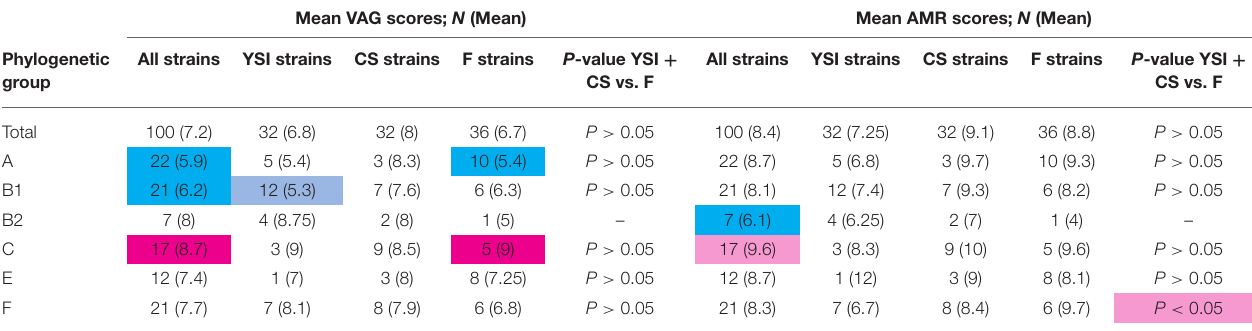
TABLE 4 | Virulence-associated genes and antimicrobial resistance scores of avian Escherichia coli isolates by phylogenetic groups. Mean VAG scores; N (Mean) Mean AMR scores; N (Mean) Phylogenetic All strains YSI strains CS strains F strains P -value YSI + All strains YSI strains CS strains F strains P -value YSI + group CS vs. F